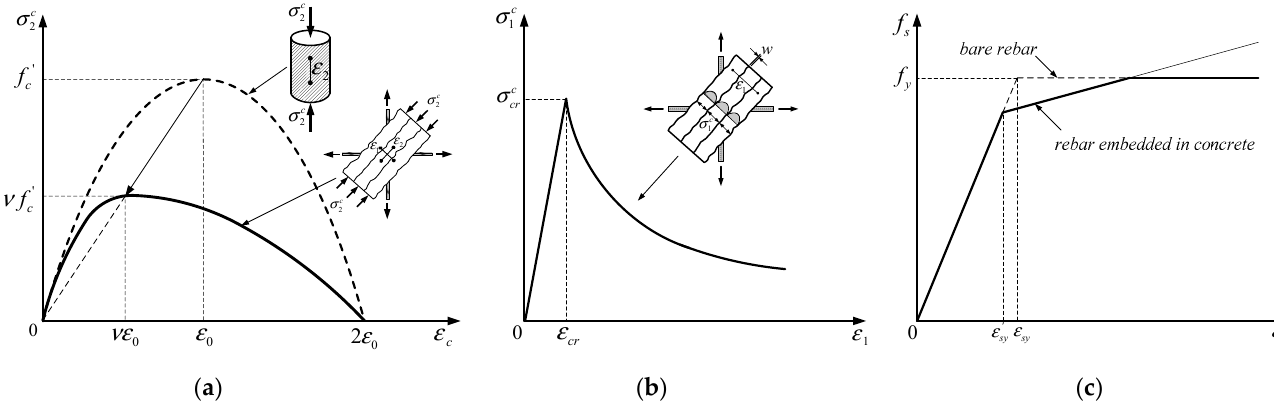
Figure 4. Constitutive relationships of used materials: ( a ) concrete in compression; ( b ) concrete in tension; ( c ) rebar in tension.